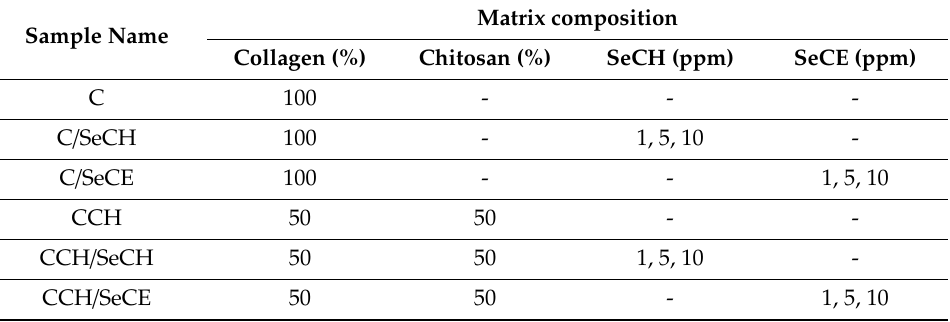
Table 1. Matrix composition summary of collagen (C) and chitosan (CCH) sca ff olds both pure